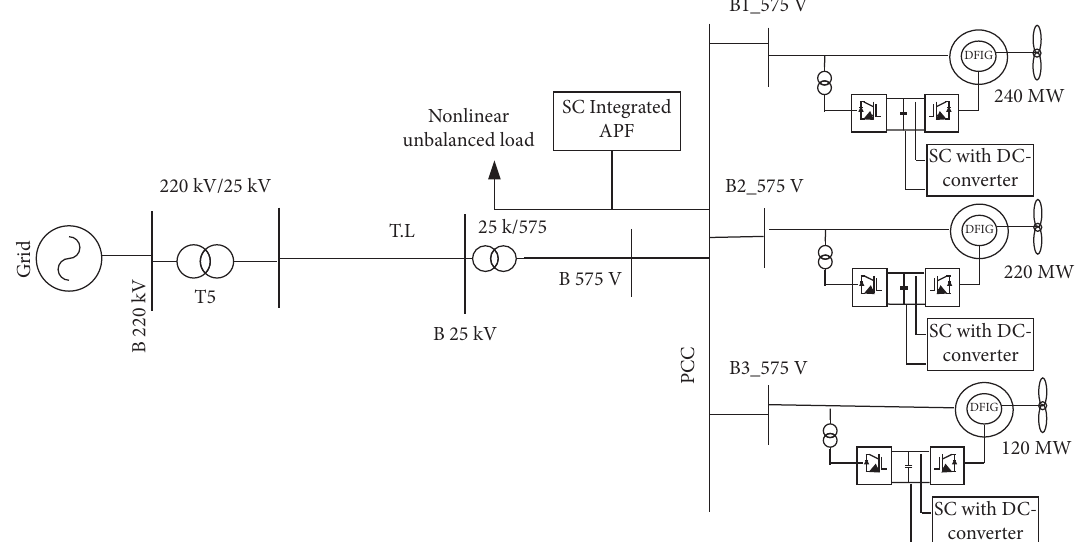
Figure 11: Layout of the studied